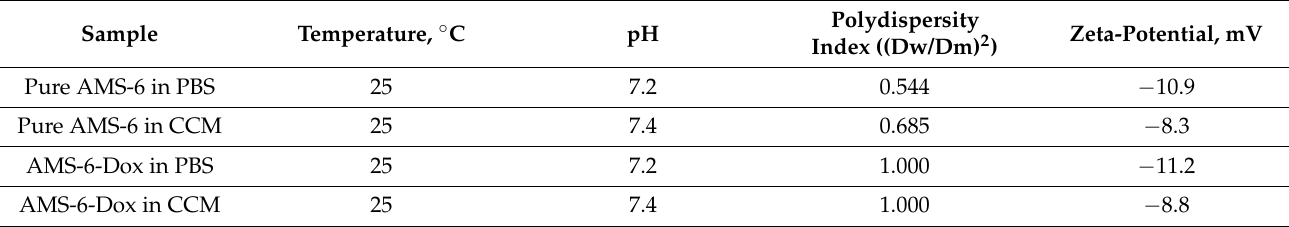
Figure A15. ( a ) Typical TEM images of calcined AMS-6 mesoporous material showing a high degree of mesoporous order and ( b ) schematics of the of AMS-6 structure. ( c ) Kinetics of Dox release from AMS-6-Dox vs. the free Dox drug dissolution in PBS. Table A5. Zetapotential of AMS-6 and AMS-6-Dox